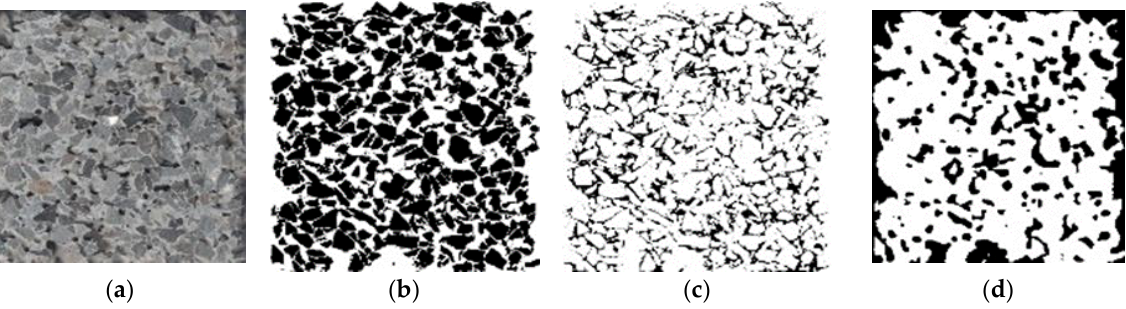
Figure 13. Typical analysis of mesostructure on the pervious concrete with 8 wt% Na 2 O as water glass content. The side length of images is 100 mm. ( a ) Optical image and binary images of ( b ) aggregate, ( c ) paste and ( d ) pore.